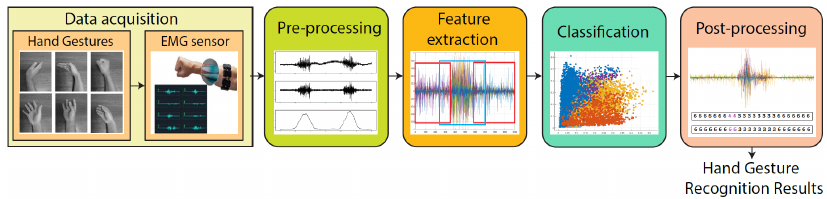
Figure 1. Hand gesture recognition architecture. It can be observed that the proposed architecture is composed of five stages, which are data acquisition, pre-processing, feature extraction, classification, and